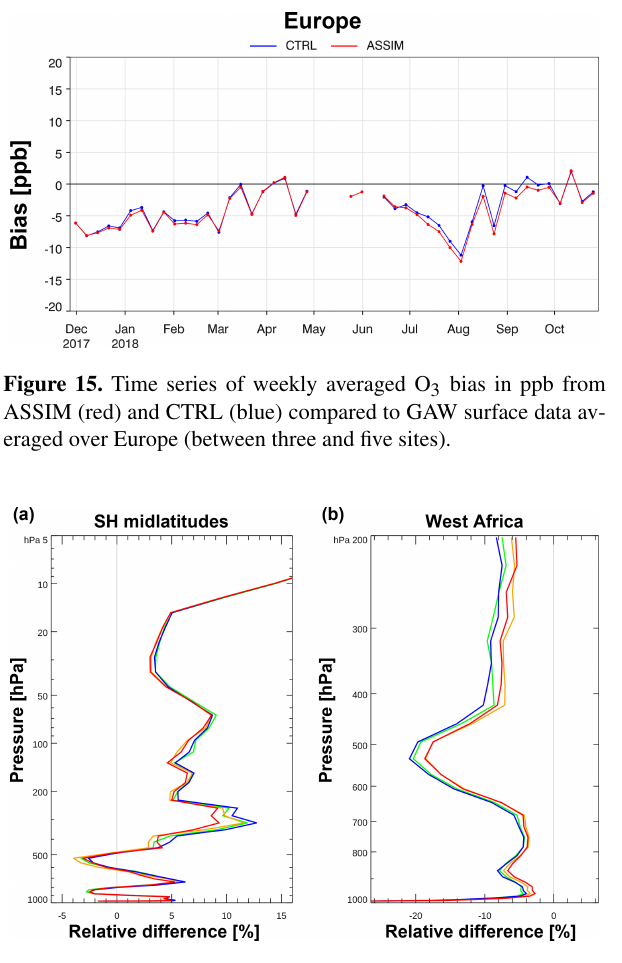
Figure 16. Mean relative O 3 difference in percent for FMA 2018 against (a) ozone sondes at SH midlatitudes and (b) IAGOS air- craft data at West African airports from ASSIM (red), ASSIM-OMI (orange), CTRL (blue) and CTRL-OMI